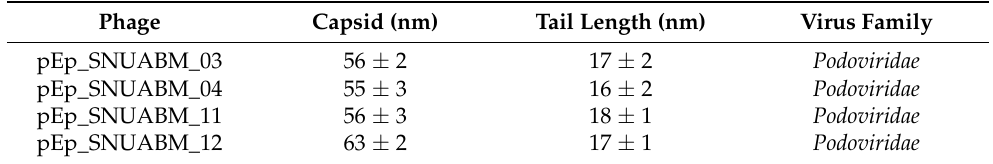
Figure 1. Morphological observation by transmission electron micrographs of Erwinia pyrifoliae phages ( A ) pEp_SNUABM_03, ( B ) pEp_SNUABM_04, ( C ) pEp_SNUABM_11, and ( D ) pEp_SNUABM_12. Scale bar = 50 nm. Table 1. Morphological characteristics of Erwinia